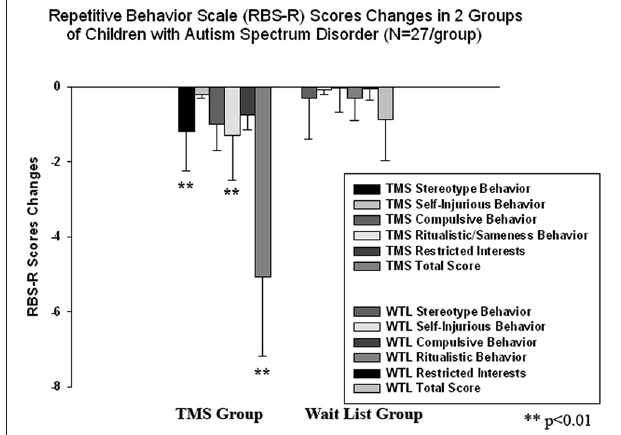
− 4.29 ± 5.9, 95% CI from − 1.95 to − 6.63, t (